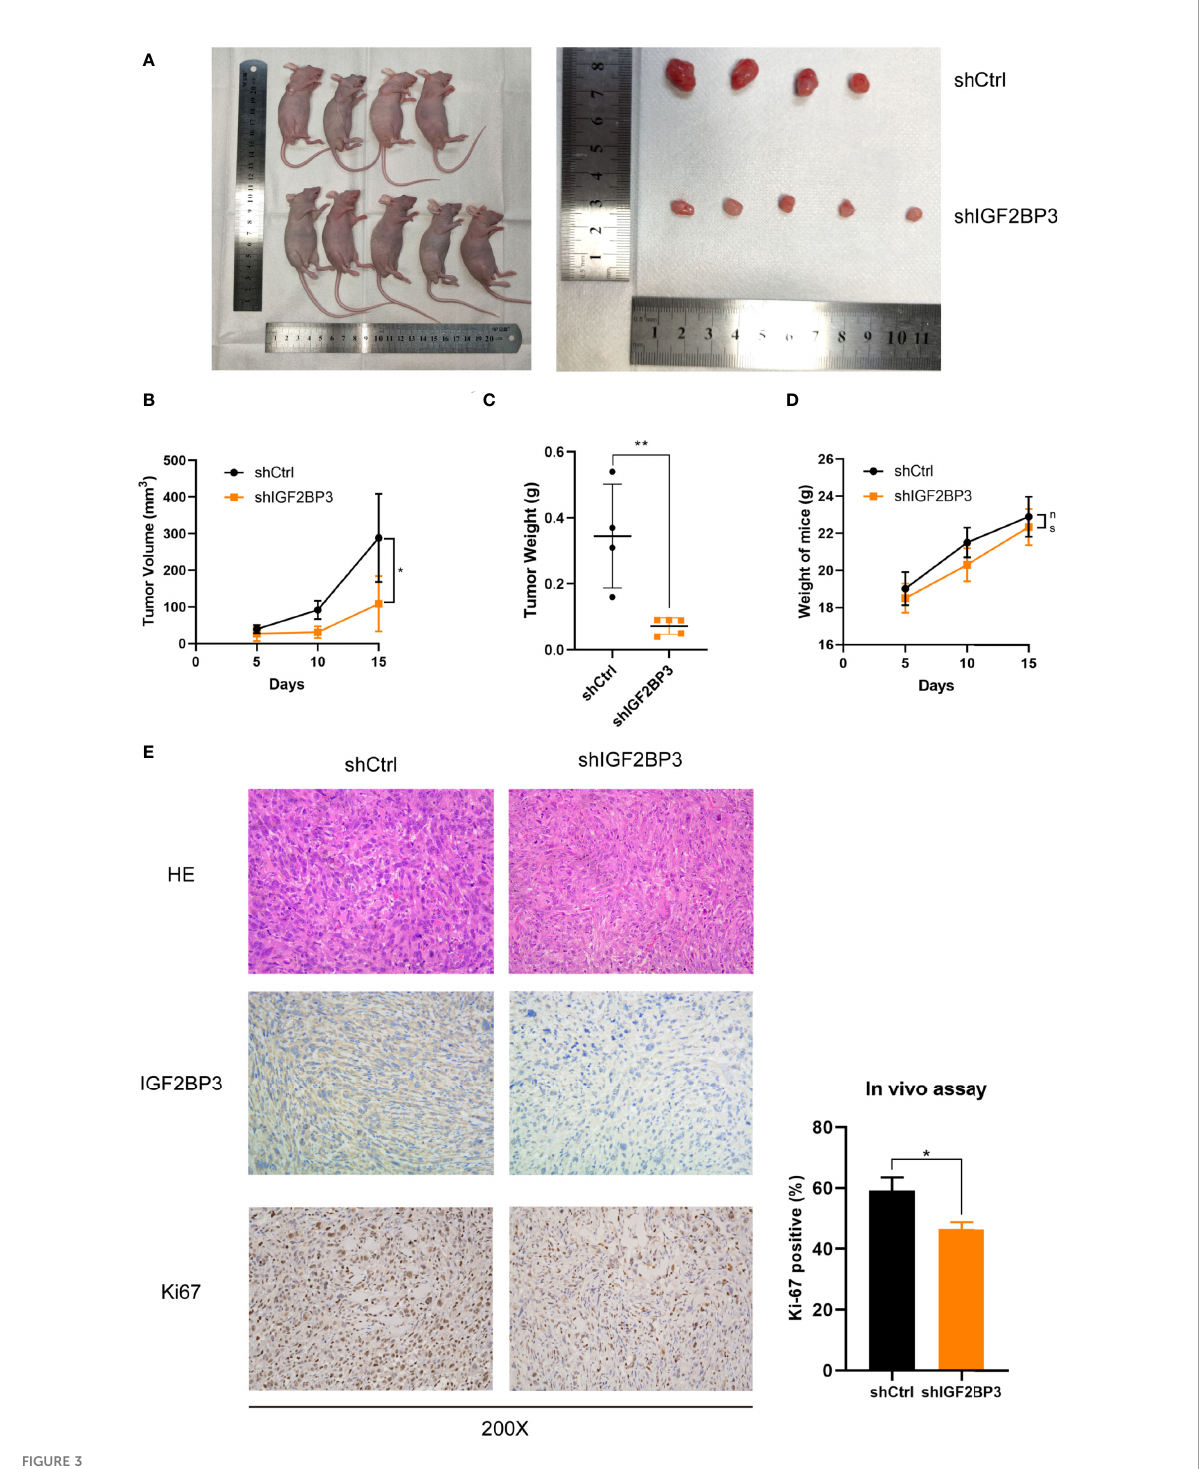
FIGURE 3 Loss of IGF2BP3 impacted GBC tumor growth in vivo . (A) NOZ cells from shIGF2BP3 and shCtrl groups were subcutaneously transplanted into nude mice and xenograft tumors were developed. (B) Tumor size was measured in order to generate tumor growth curves according to the mean tumor volume. (C) Tumor was weighed after surgical resection and shown above. (D) The weights of the mice were measured and the weight curves are presented based on the mean weight of each group. (E) HE and IHC staining were performed for tumor sections from each group. The Ki-67 positive cells were counted and statistically analyzed using unpaired t test. Data is shown as mean ± SD; * P < 0.05 and ** P < 0.01. ns means no signi fi cance in statistical